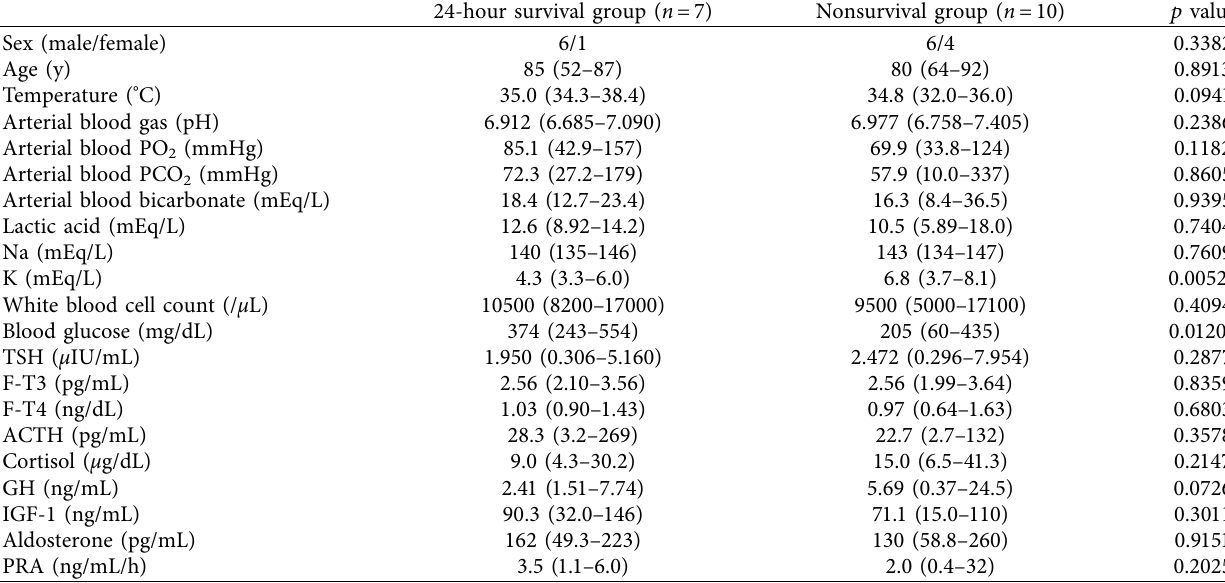
Table 4: Comparison of the 24-hour survival and nonsurvival groups in the ROSC group ( n � 17).